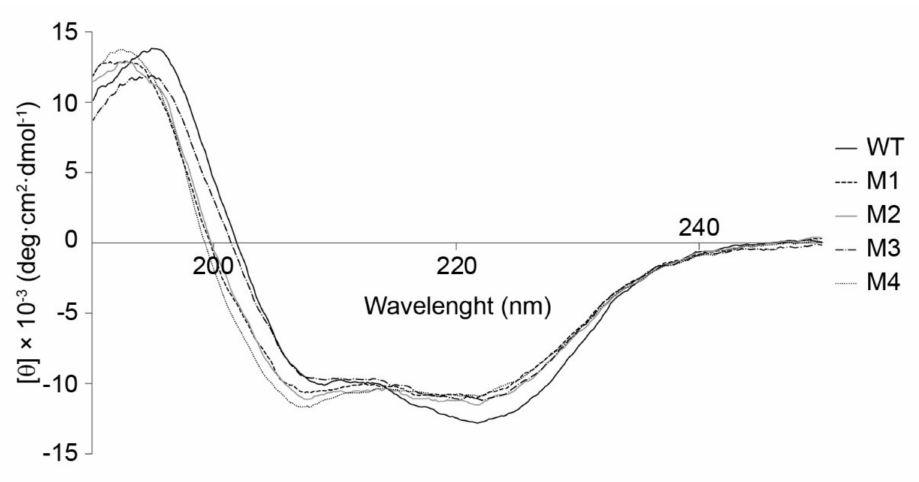
Figure 2. The CD spectra of cytochrome c (WT) and its mutant variants (M1-T78N/K79Y/